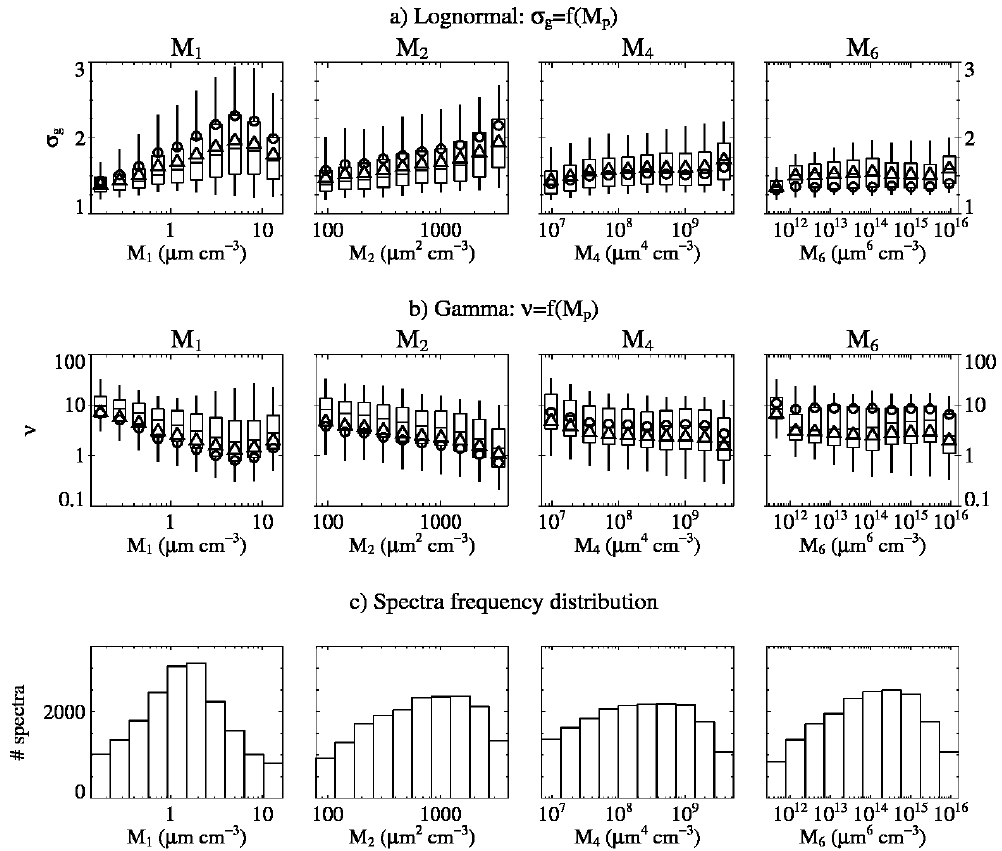
Figure 4. Statistical distribution of the shape parameter values as a function, from left to right, of the M 1 , M 2 , M 4 and M 6 moment values. The x axis is divided into 10 classes on a log scale. The box plots denote the 5th, 25th, 50th, 75th and 95th percentiles of the shape parameter distribution in each class. The circles and triangles denote the tuning parameter value that minimizes the standard deviation of the absolute error and the geometric standard deviation of the log error in each class, respectively. The top and second rows are for the lognormal function and the gamma function, respectively. The third row shows the number of sampled spectra in each moment class.